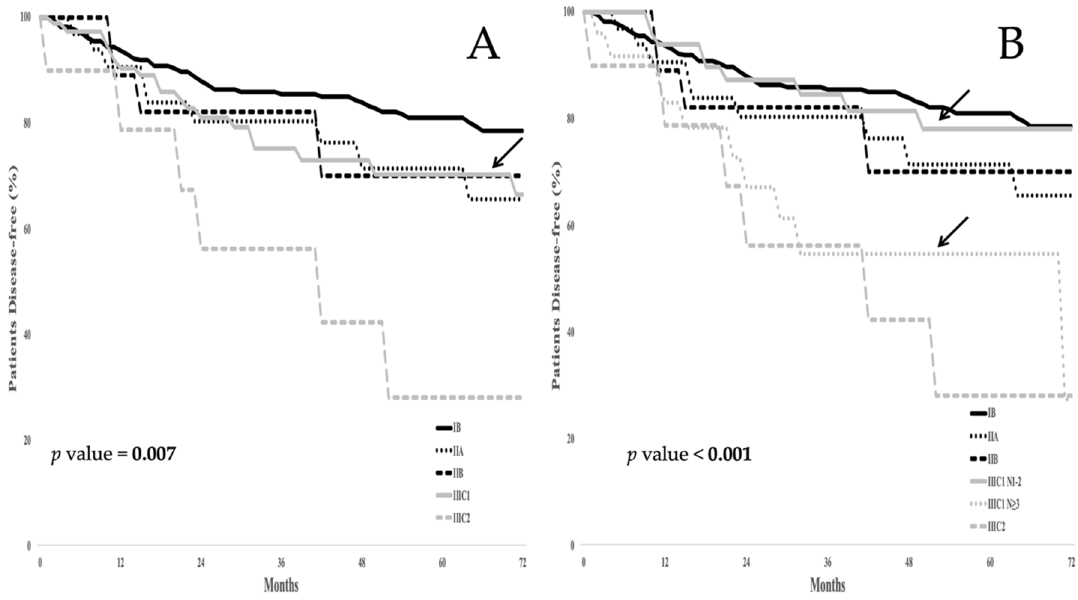
Figure 3. ( A ) Disease free survival (DFS) in the whole series according to the FIGO 2018 staging system; ( B ) DFS in the whole series according to the proposed FIGO 2018 staging system. Arrows highlight the DFS curve for stage IIIC1 in panel A, as well as the subgroups N1-2 and n > 2 in panel B.